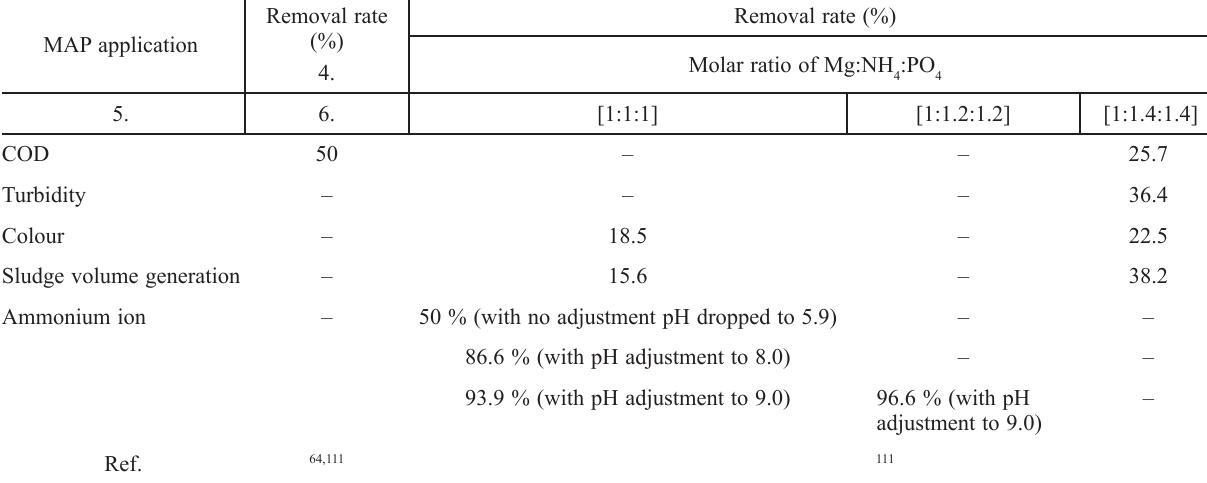
Table 6 – Removal rate of the effluent parameters for MAP application MAP